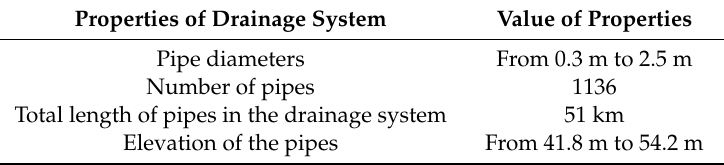
Table 2. The main properties of the drainage system in the SWMM